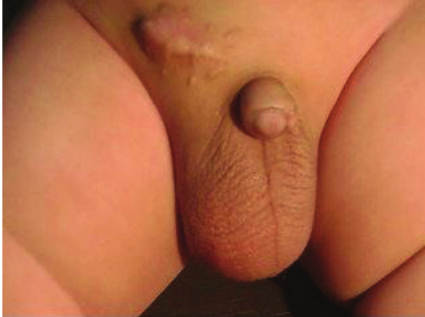
Figure 5: (a) Testicular Doppler U/S showed no signs of ischemia with good blood flow. (b) Testicular Doppler U/S showed poor blood